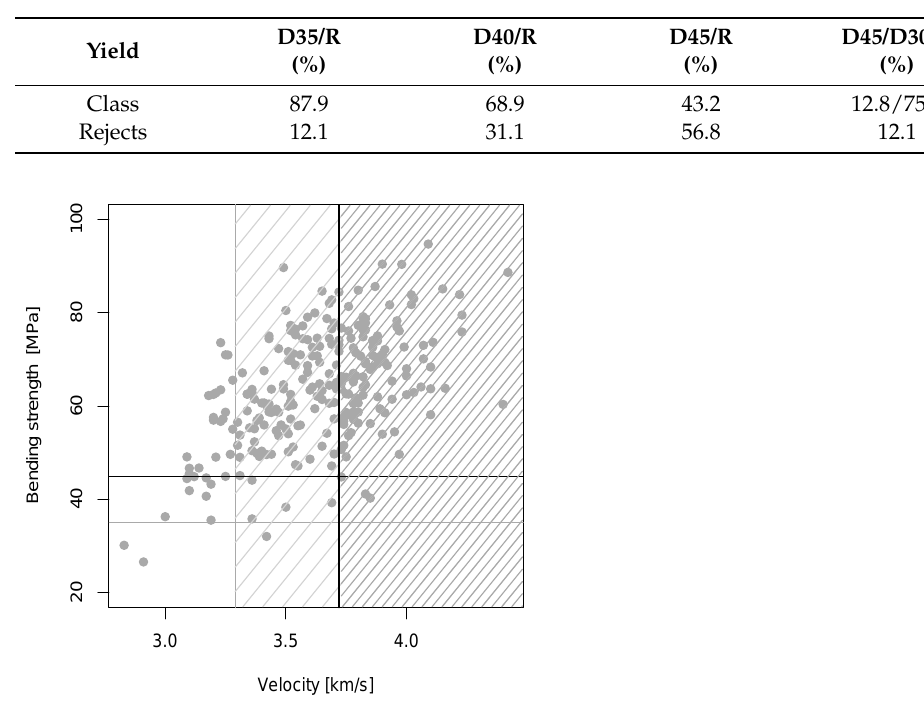
Table 5. Yields achieved by wet grading, using the velocity unadjusted for moisture content.